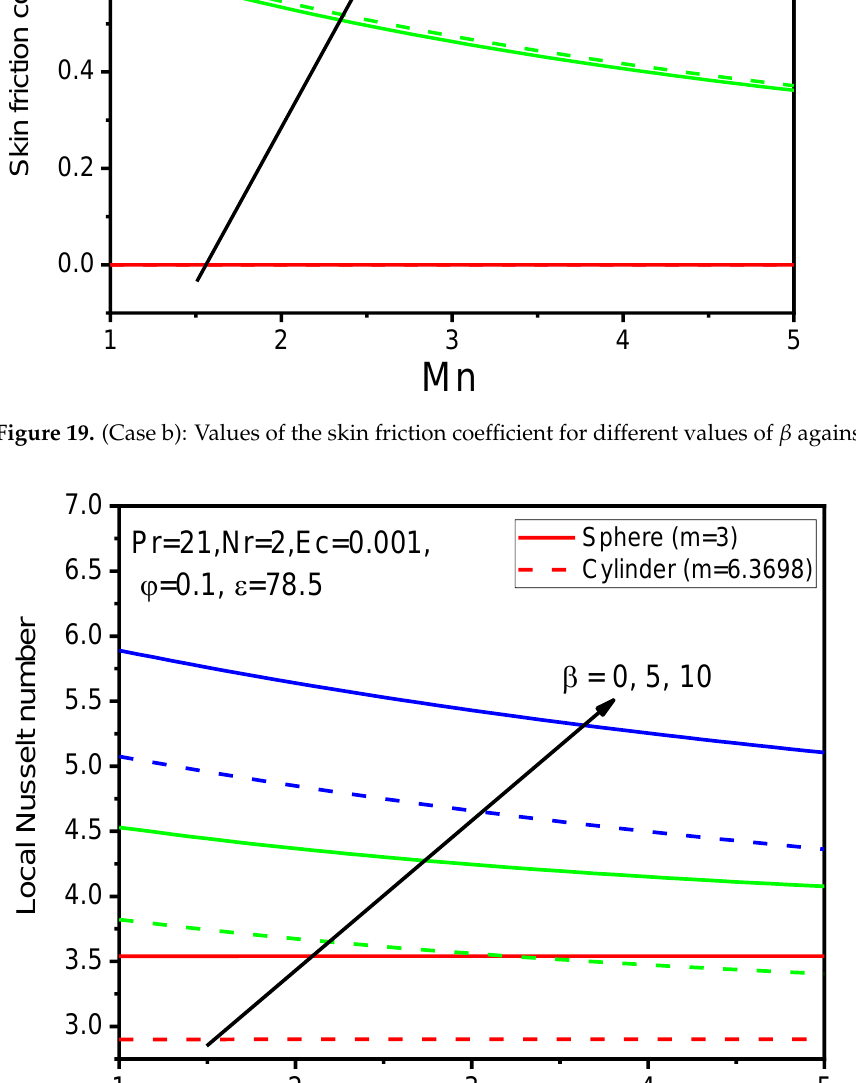
Figure 20. (Case b): Values of the local Nusselt number for different values of β against Mn . For the ferromagnetic interaction parameter, the velocity profile is reduced and, conse- quently, the temperature profile is also decreased. This is due to the presence of the Kelvin force which is also known as resistive force, and it appears because of the fluid polarization at the inflow region (see Figures 4 and